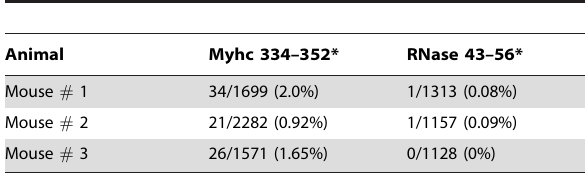
Table 1. Quantitative analysis of PLP 139–151-dext + CD4 + T cells in the brains of EAE mice by confocal microscopy.